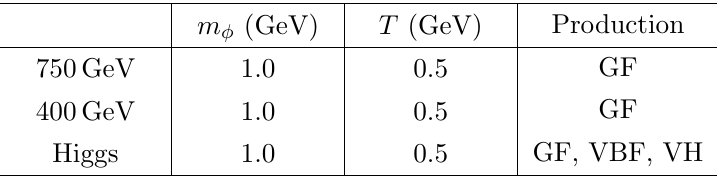
Table 1. Signal benchmark